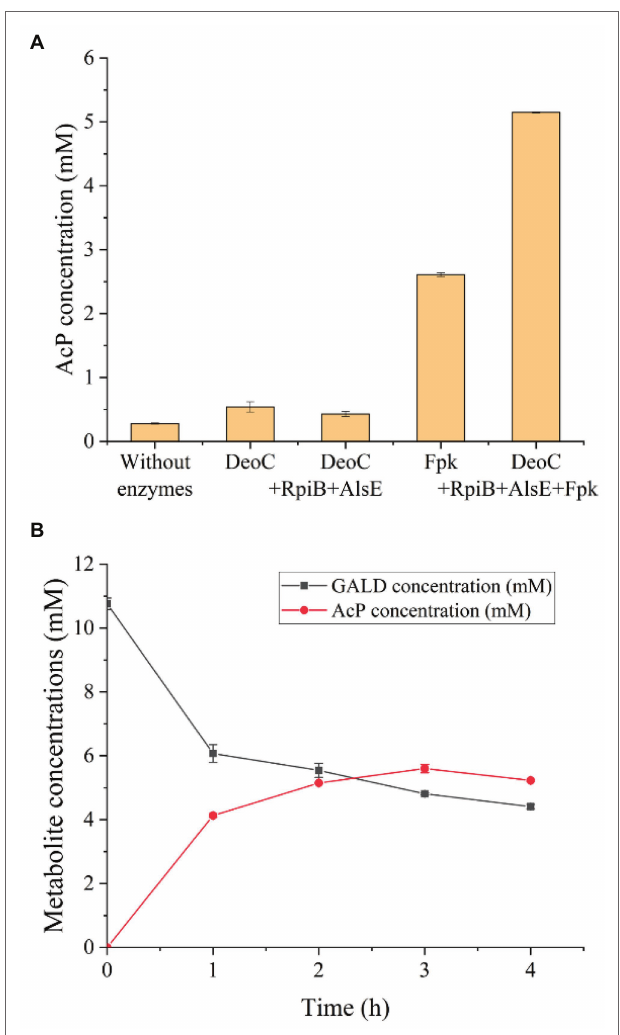
FIGURE 8 | Efficiency evaluation of the GAPA pathway. (A) AcP concentrations produced from 2.5 mM E4P and 10 mM GALD after 2 h using different enzymes (DeoC 2 mg/ml, RpiB 2 mg/ml, AlsE 2 mg/ml, and/or Fpk 1 mg/ml). (B) Time profile of GALD and AcP concentration in reaction system containing 10 mM GALD, 2.5 mM E4P, 2 mg/ml DeoC, 2 mg/ml RpiB, 2 mg/ ml AlsE, and 1 mg/ml